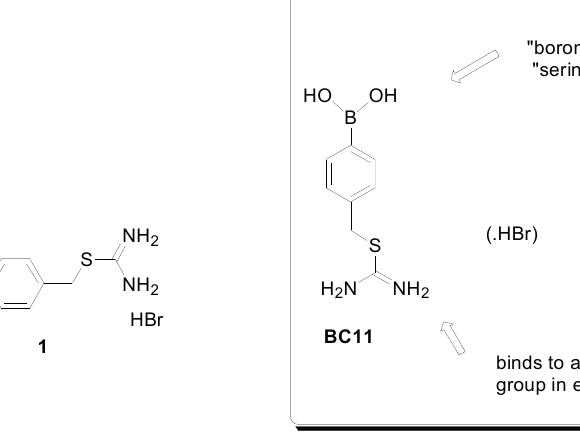
Figure 1. Thioronium salts in this